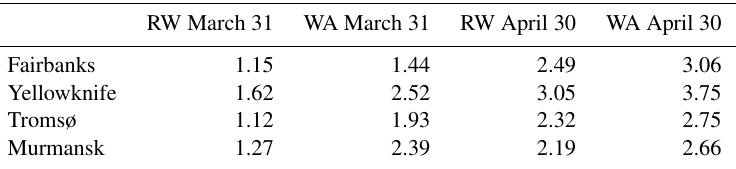
Table 1. Surface UV index for the SD-WACCM grid point nearest to Fairbanks, USA (64.84 ◦ N, 147.7 ◦ W), Yellowknife, Canada (62.46 ◦ N, 114.22 ◦ W), Tromsø, Norway (69.66 ◦ N, 18.94 ◦ E), and Murmansk, Russia (68.96 ◦ N, 33.08 ◦ E). The UV index is calculated for 31 March and 30 April for both the RW and WA simulations, using total column ozone and solar zenith angle at noon under clear-sky conditions in each grid